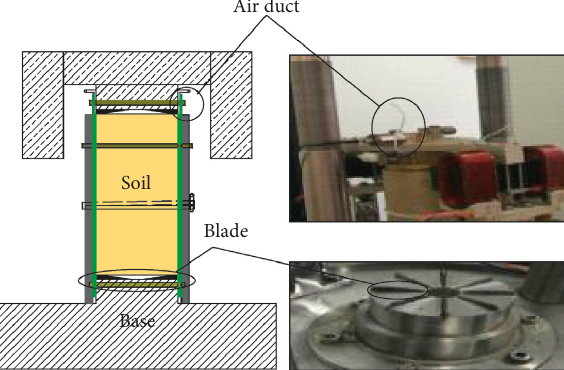
Figure 14: Schematic diagram of processes ③ and ④ .